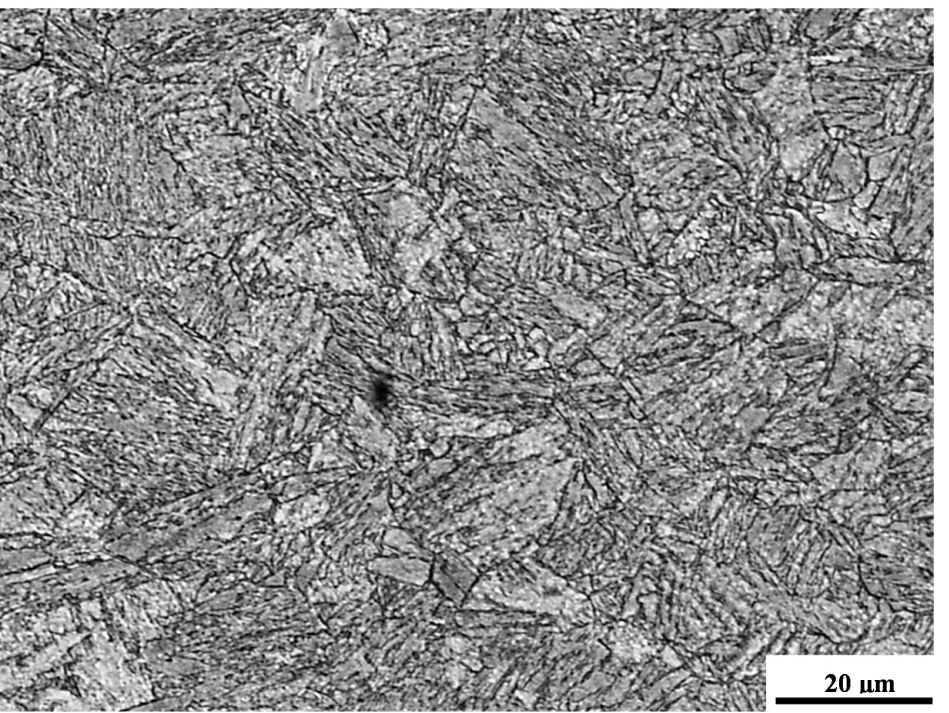
Figure 5. Microstructure of the joint (W90). Visible martensite and course ferrite (LM). In addition to martensite, coarse-grained ferrite was observed. Only the application of micro-jet cooling after MAG welding made it possible to obtain much more fragmented ferrite (shown in Figure 6).